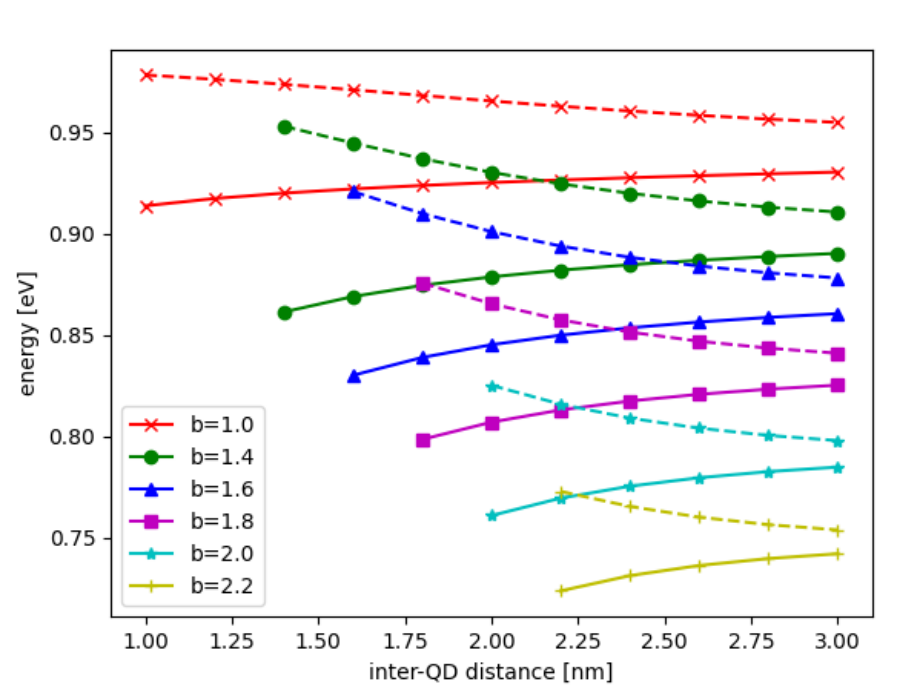
Figure 3. The DQD energies as a function of inter-QD distance d ; the solid and dash lines represent the energies of the bonding and anti-bonding states, respectively. Different lengths of QD base b are shown in different colors and symbols.